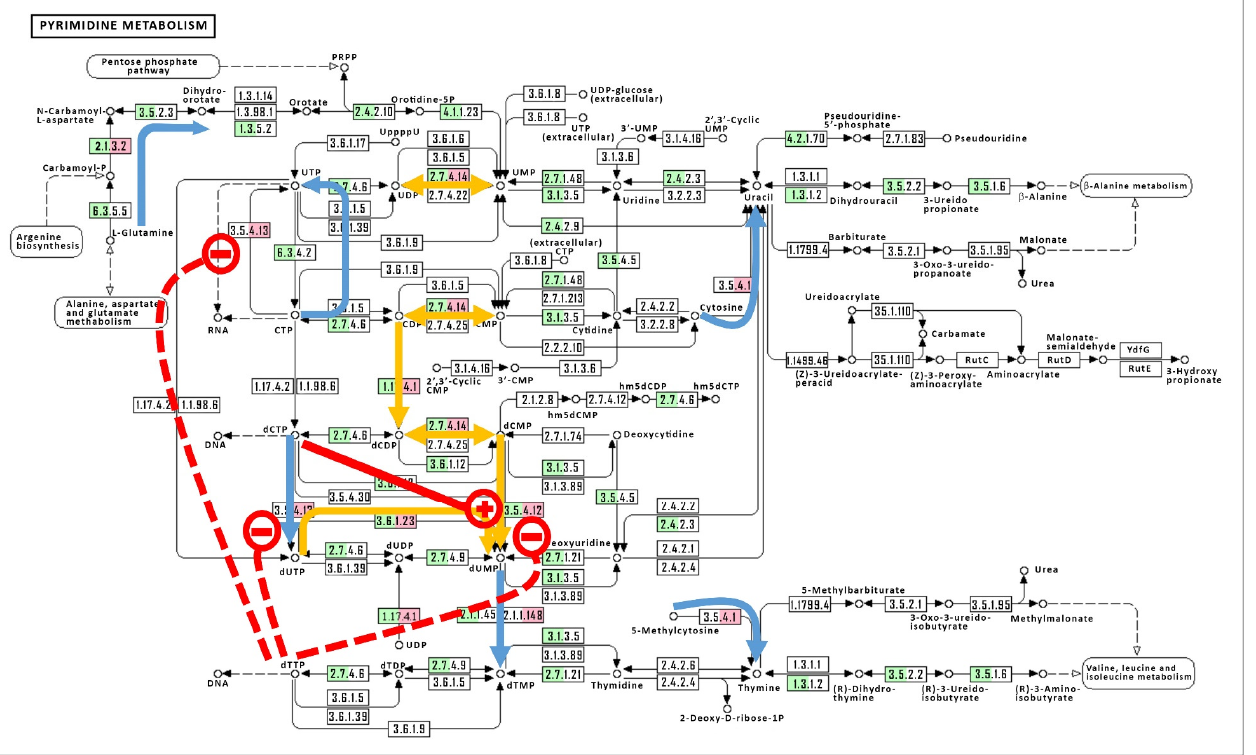
Figure 2. KEGG pathway of the pyrimidine metabolism annotated with C. variabilis NC64A and PBCV-1 genes and comprehensive “roadway” predictions. C. variabilis NC64A genes are colored green, and PBCV-1 genes are red. This figure summarizes the virus-mediated metabolic fluxes where viral genes either (i) complement the pathway by providing a function not identified in the host genome, and we refer to this as a “roadway by-pass” (indicated by a blue arrow); or (ii) augment the pathway by providing a function that is present in the host genome, and we refer to this as a “roadway passing lane” (indicated by a yellow arrow). Metabolite-directed flux rates of virus- encoded enzymes are sensitive to either positive feedback regulators (indicated by a red solid line with a plus sign “+”) or negative feedback regulators (indicated by a red dashed line with a minus sign “ − ”).